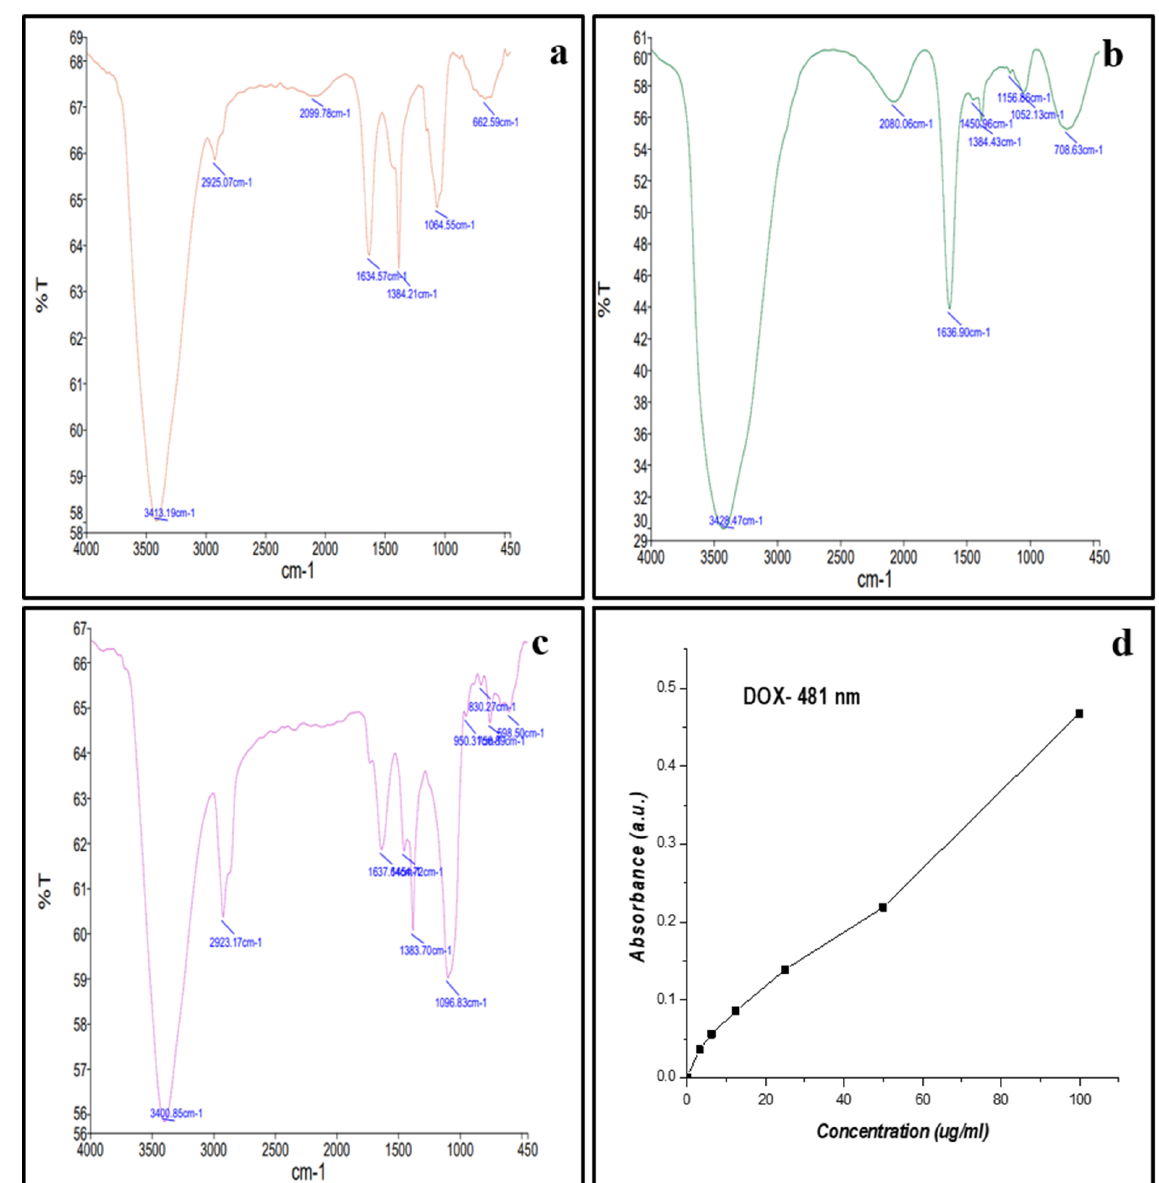
Figure 5. ( a ) FTIR spectra of ZnONPs ( b ) Doxorubicin ( c ) DOX-ZnONPs and ( d ) Standard graph of pure Doxorubicin to calculate drug loading efficiency (481